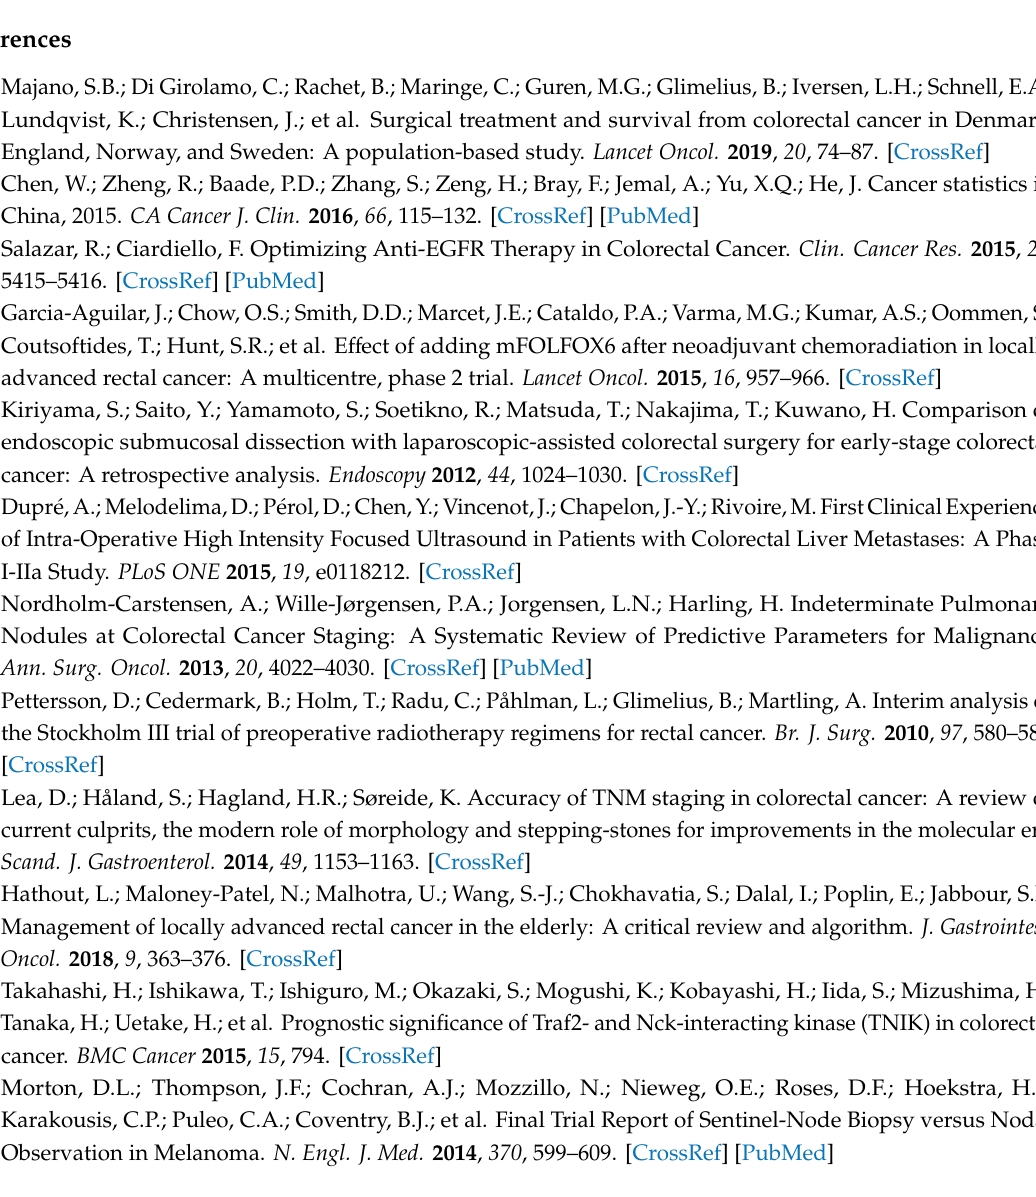
Figure S1: RT impact on biomarkers in PT analyzed by Pearson chi-square, Table S1: Clinicopathological characteristics of patients in RT group and Non-RT